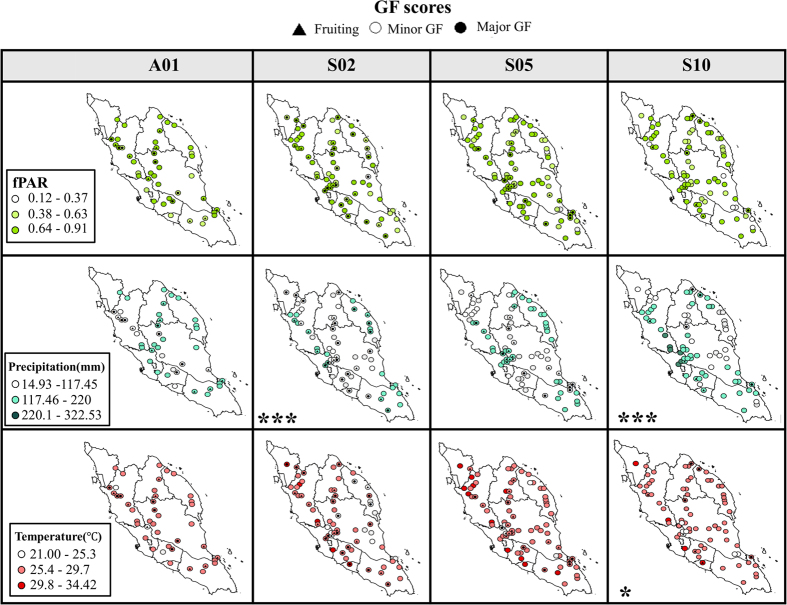
Antecedent climatic conditions (fPAR, precipitation, temperature) variability at forest during large-scale GF events.* and *** indicate significant parameter at p < 0.05 and p < 0.0001 respectively. All maps were developed using ArcGIS v.10 (www.esri.com) and combined using GIMP v.2.8.14 (www.gimp.org).